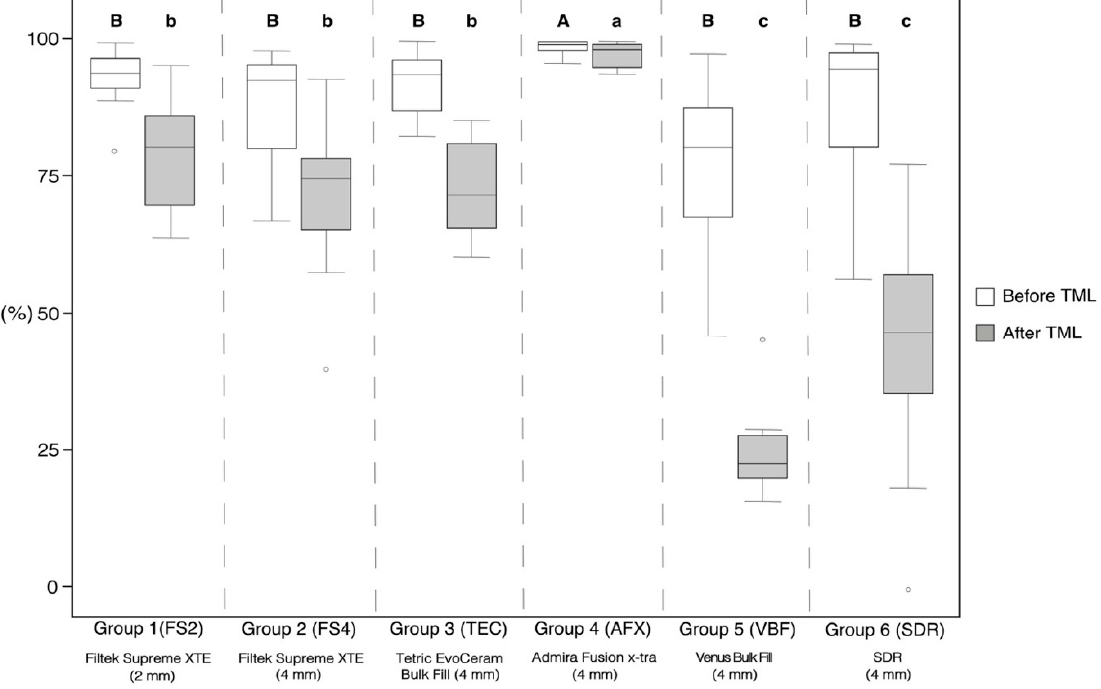
Table 2. Margin integrity, separately in enamel and dentin, given as percentages of continuous margins (mean ± standard deviation) for all experimental groups before and after thermo-mechanical loading (TML).